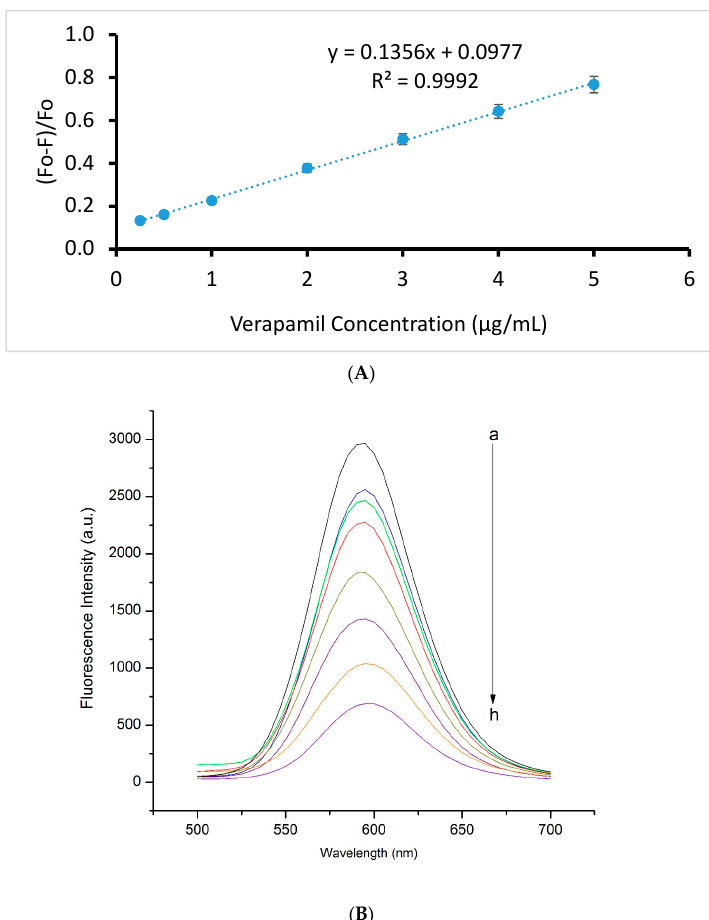
Figure 7. ( A ) Relationship between (Fo-F)/Fo and verapamil HCl concentration. ( B ) Effect of addition of different concentrations (µg/mL) of verapamil HCl on FL intensity of CdTe/CdS/ZnS QDs. Concentrations are as follows: (a) 0; (b) 0.25; (c) 0.5; (d) 1; (e) 2; (f) 3; (g) 4; and (h) 5.